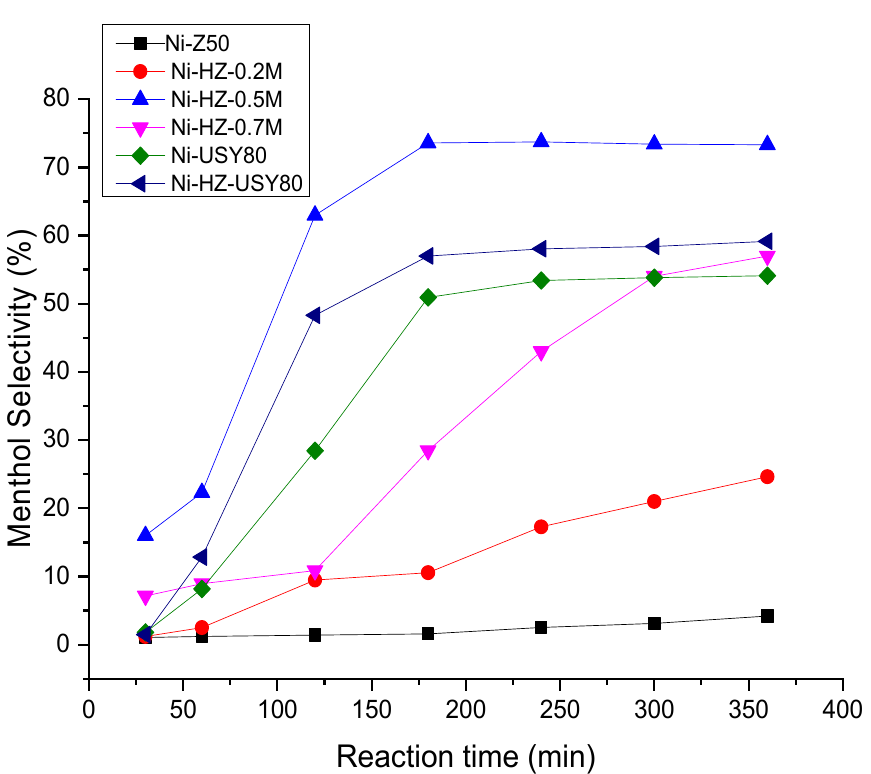
Figure 10. The catalytic performance of catalysts in citral hydrogenation for menthol synthesis with respect to time via citral hydrogenation.